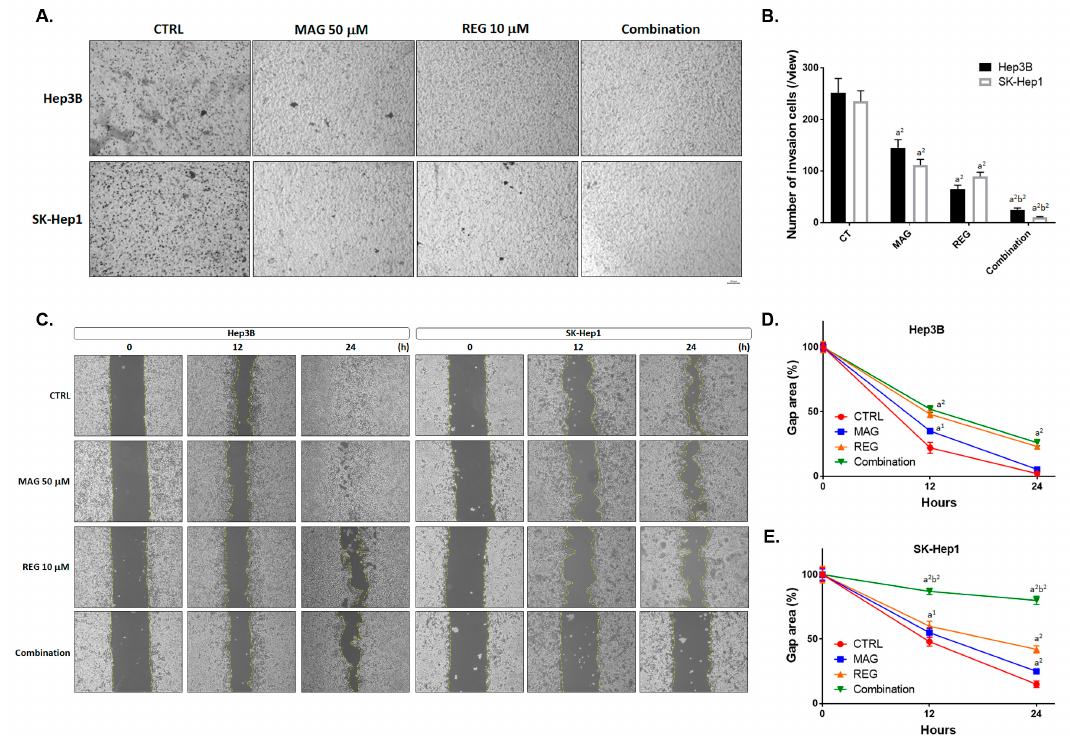
Figure 3. The metastasis inhibition effect of regorafenib was enhanced by magnolol. Hep3B and SK-Hep1 cells were treated with 10 µ M regorafenib, 50 µ M magnolol, and a combination for 48 h and subjected to a transwell invasion assay and wound healing assay. ( A ) A photograph of the invasion transwell and ( B ) the quantification results of the invasion cells. ( C ). A photograph of the migration cell pattern and the quantification results of the migrated gap area in ( D ) the Hep3B and ( E ) SK-Hep1 cells. (a 2 p < 0.01 vs. CTRL; b 2 p < 0.01 vs. 10 µ M REG or 50 µ M MAG; CTRL: Control, MAG: magnolol; REG: